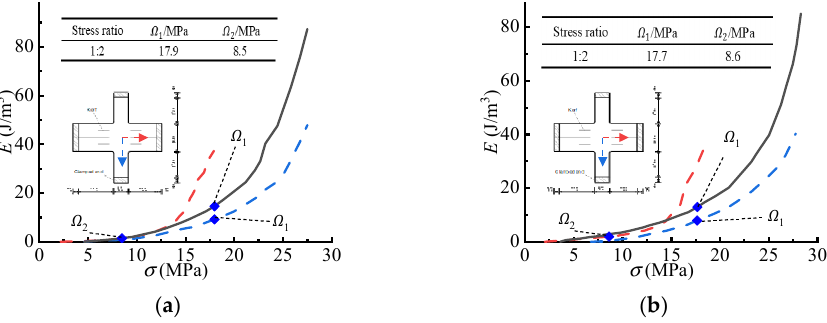
Table 7. The verification of Equation (16) using the data ( Ω 1 , Ω 2 , and Ω eq